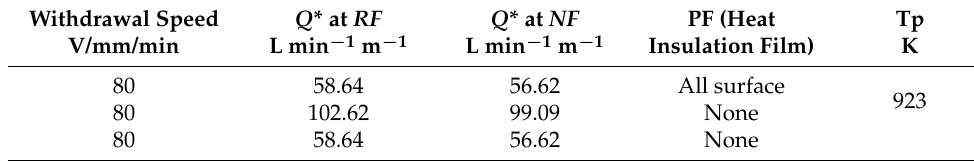
Table 2. Casting parameters of semi-continuous